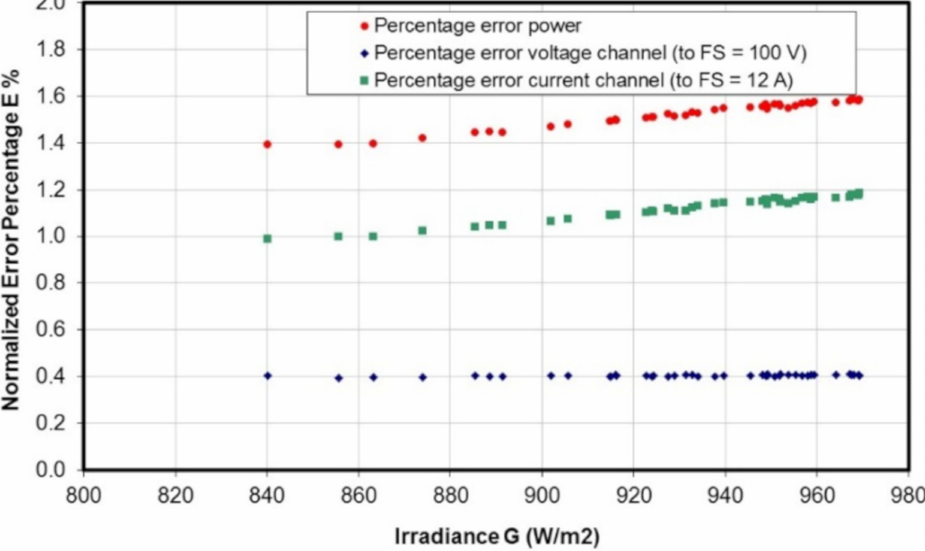
Figure 12. Variation of the percentage error of the power, the voltage channel and the current channel for the monocrystalline silicon PV module.